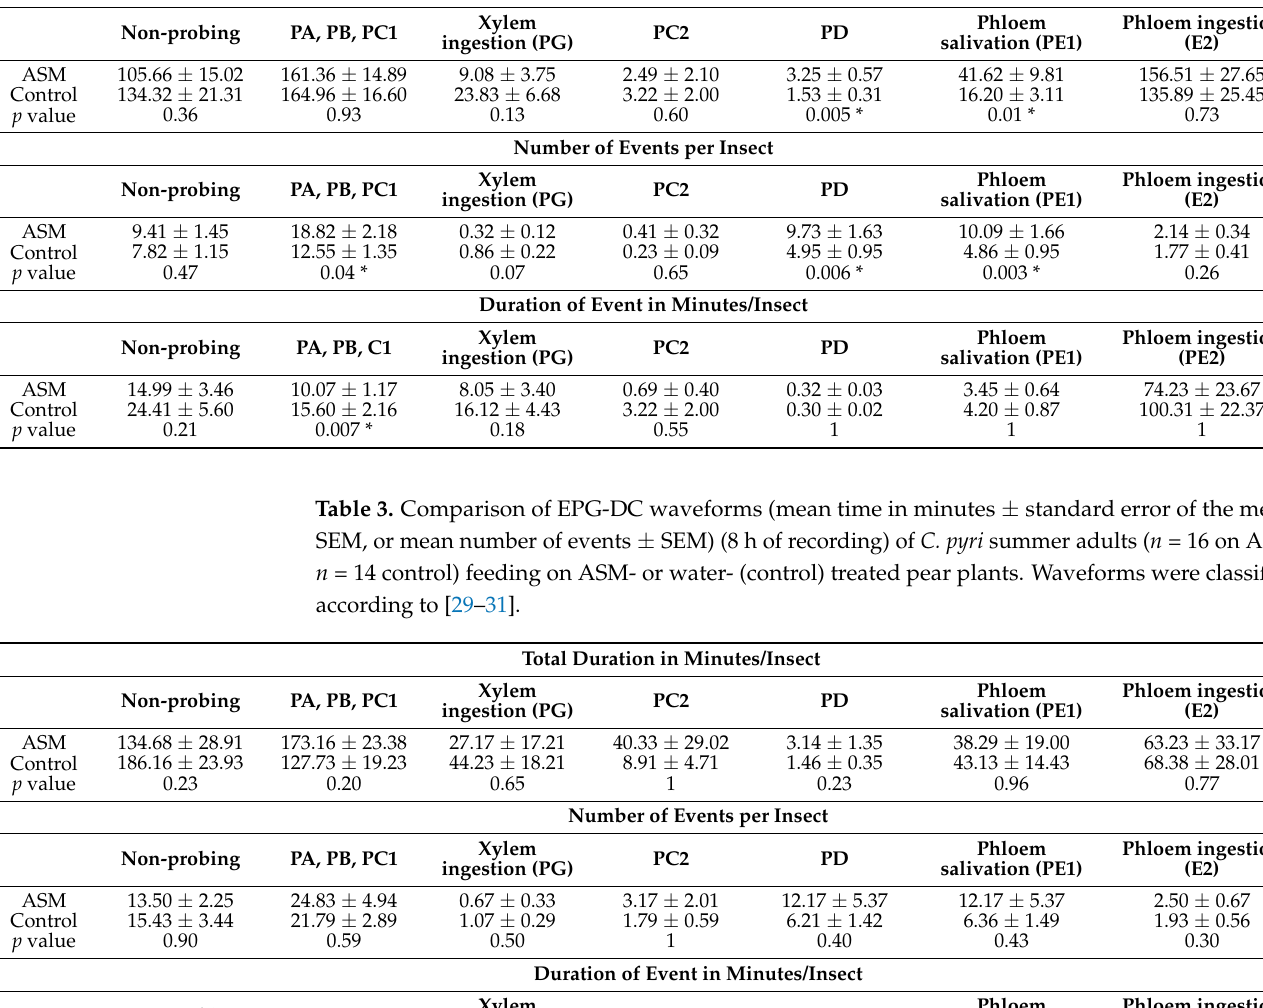
Table 2. Comparison of EPG-DC waveforms (mean time in minutes ± standard error of the mean, SEM, or mean number of events ± SEM) (8 h of recording) of C. pyri nymphs ( n = 22 on ASM, n = 22 control) feeding on ASM- or water- (control) treated pear plants. Waveforms were classified according to [29–31]. * p < 0.05 vs. control according to the Mann-Whitney test. Total Duration in Minutes/Insect